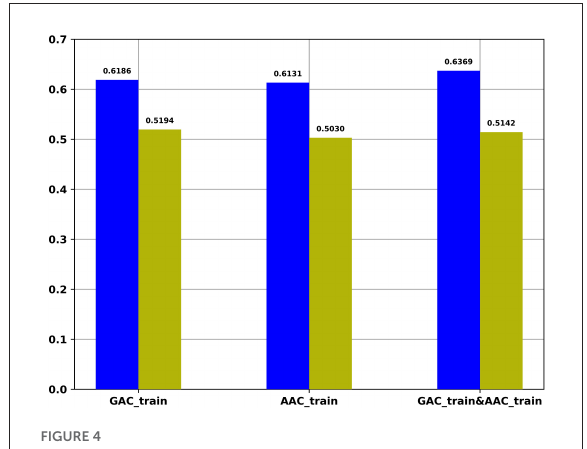
FIGURE4 The Pearson correlation coefficient of multi-task models on different training datasets. Blue: The Pearson correlation coefficient obtained by regression task of multi-task models; Yellow: The Pearson correlation coefficient values obtained based on the predicted probability of the classification task of multi-task models and the target values of the regression task of multi-task models.